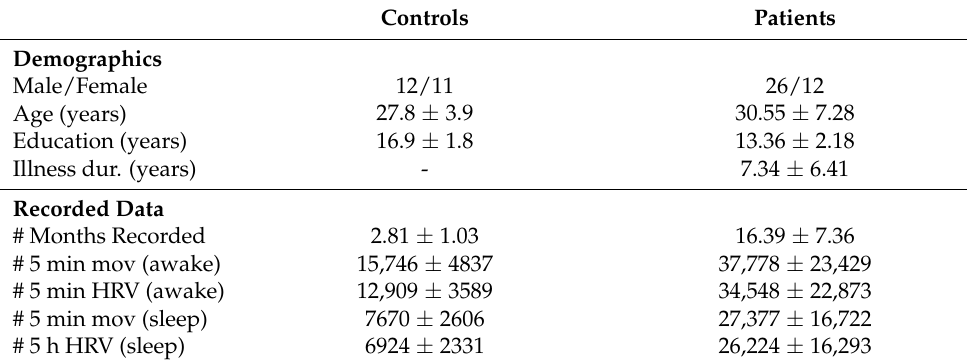
Table 2. Demographics information of controls and patients at the time of recruitment, illness information and amount of recorded data for each group during wakefulness and sleep (up to April